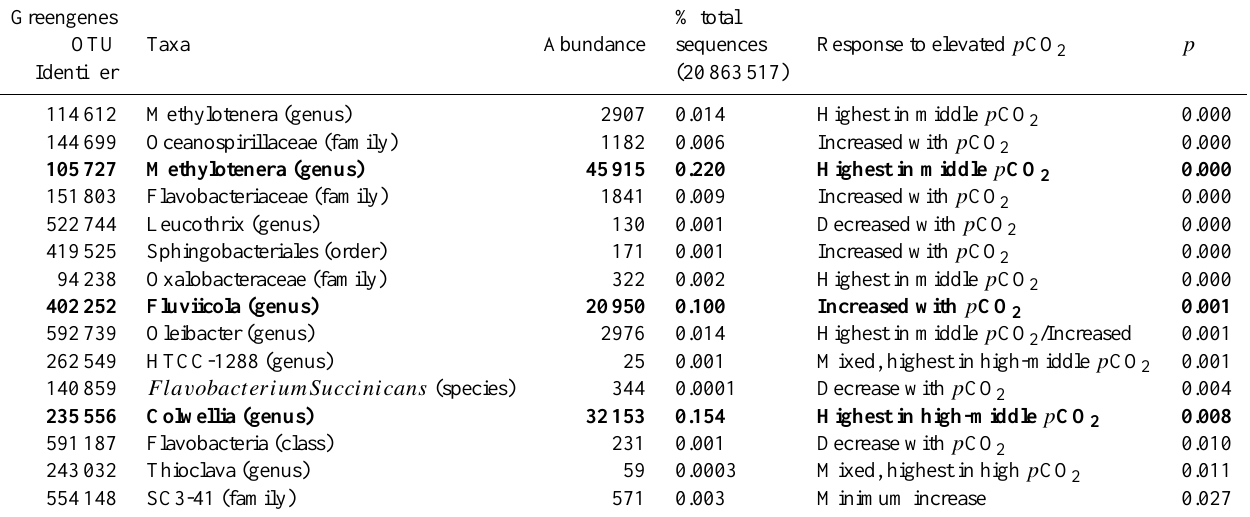
Table 4. Bonferroni-corrected g-test of significance ( p < 0 . 05) listing 15 taxa significantly correlated with CO 2 , for both small and large size fraction; bold highlights mark the taxa presented in Fig. 4. Greengenes OTU identifiers refer to prokMSA ids in the Greengenes database.